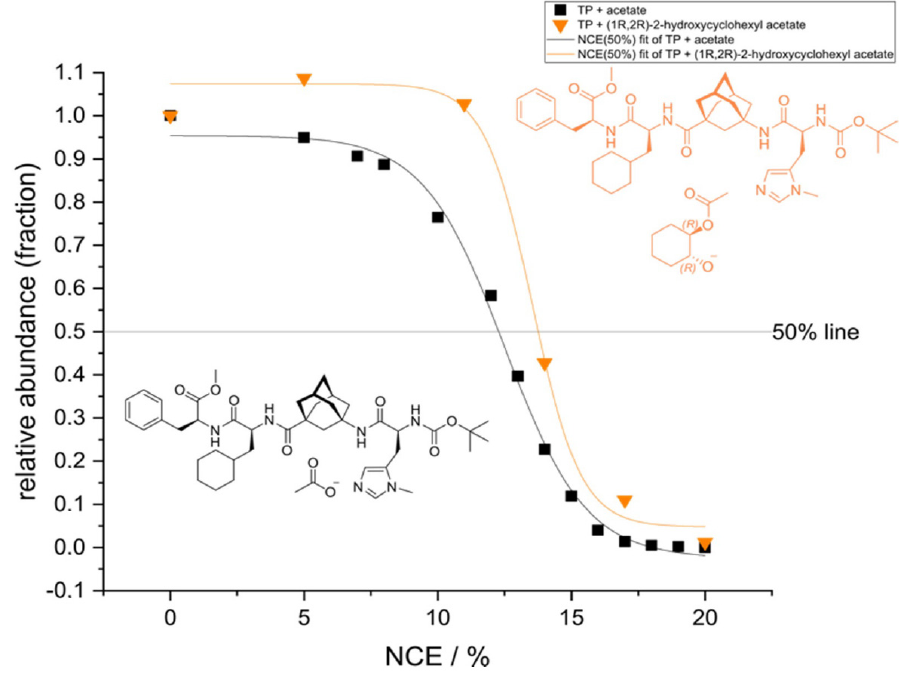
Figure 4. DoseResp [21] fit of relative abundance in dependence of normalized collision energy (NCE) of TP 1 + acetate, m/z = 819.47 (black) and reaction product complex (TP 1 + acetylated diol 12 ), m/z = 917.53 (orange). One possible charge localization of [M+AcDiol] − is shown; others are possible.